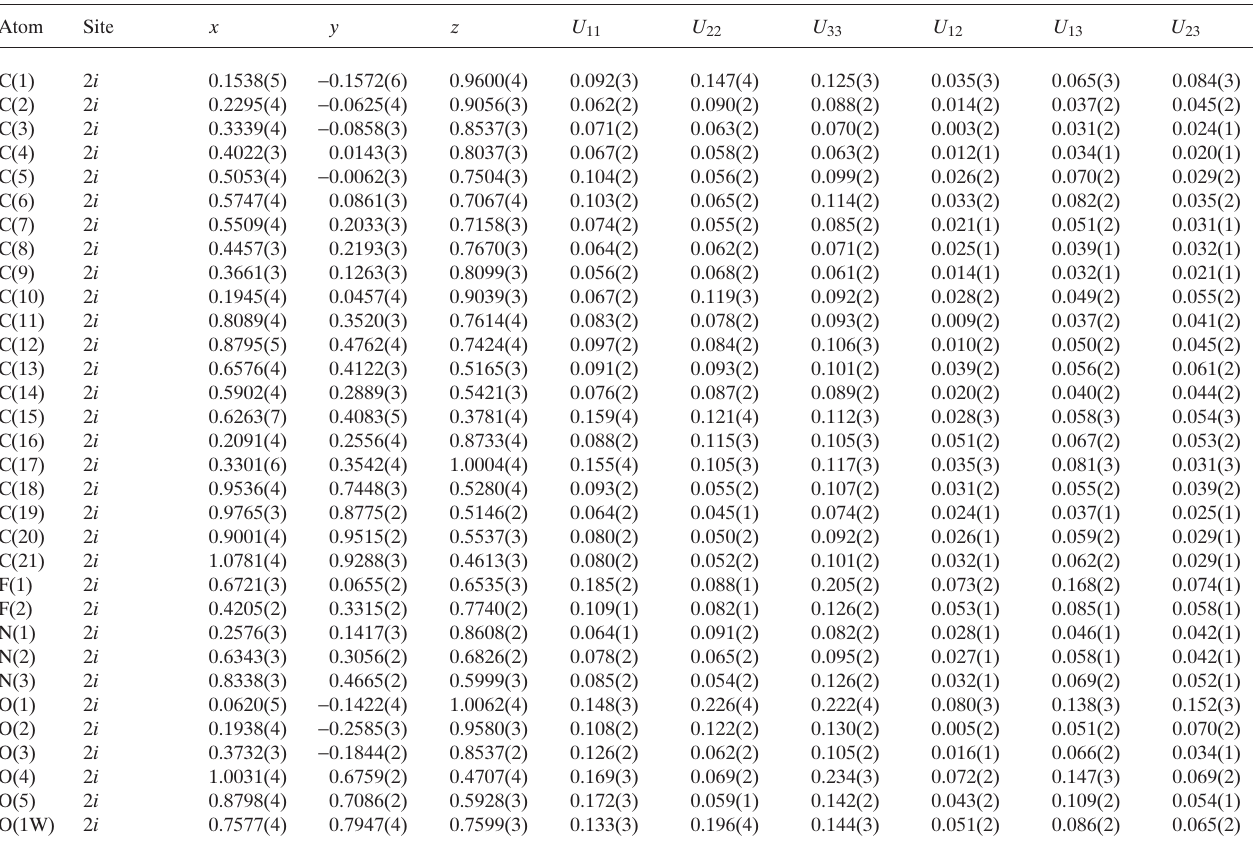
Table 3. Atomic coordinates and displacement parameters (in Å 2 )